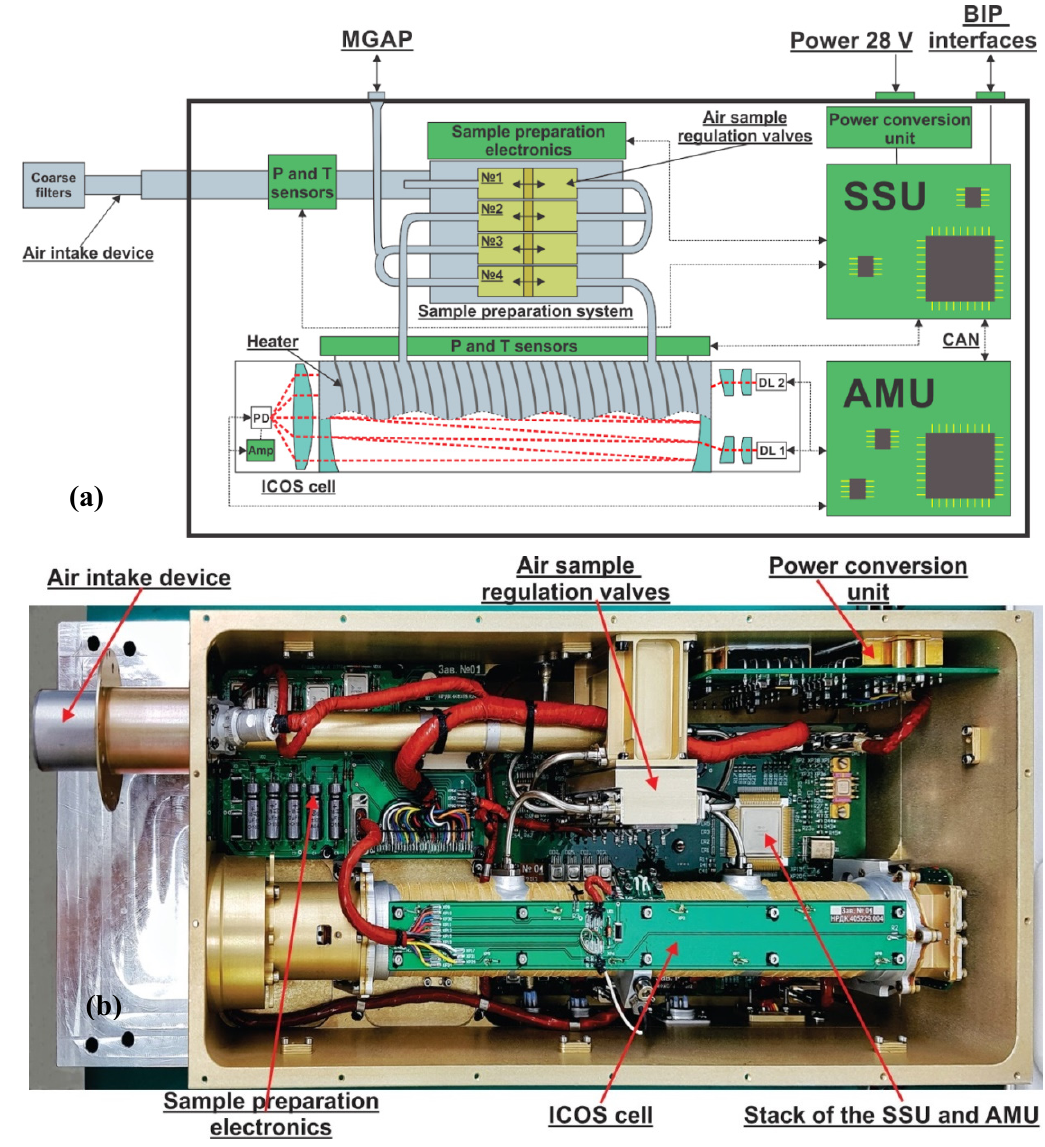
Figure 8. Principle scheme ( a ) and internal layout ( b ) of the M-DLS. SSU is service system unit, AMU is atmospheric measurements unit.